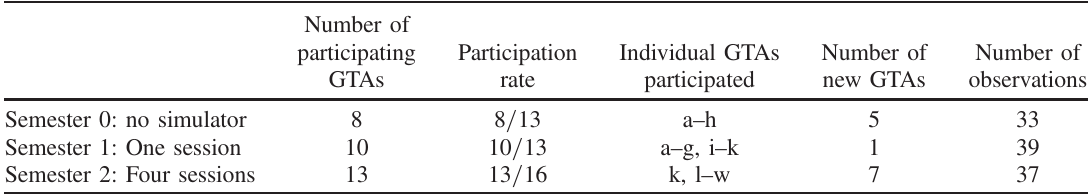
TABLE I. Number of GTAs participated in classroom observations in each semester.